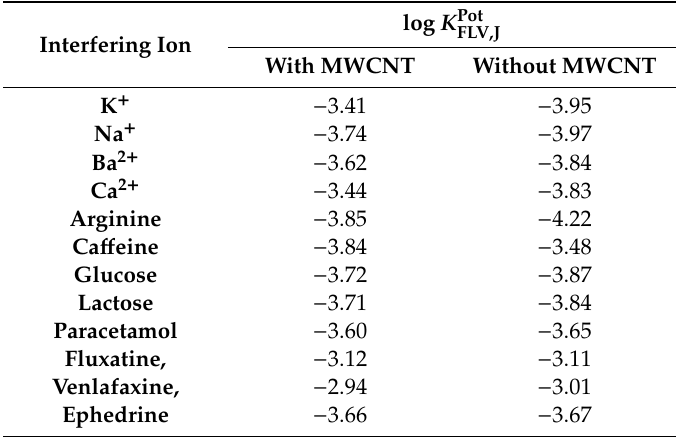
Table 2. The selectivity coe ffi cients (log log K Pot ) of the proposed sensor with and without MWCNT. FLV,J log K Pot FLV,J Interfering Ion With MWCNT Without MWCNT K + − 3.41 − 3.95 Na + − 3.74 − 3.97 Ba 2 + − 3.62 − 3.84 Ca 2 + − 3.44 − 3.83 Arginine − 3.85 − 4.22 Ca ff eine − 3.84 − 3.48 Glucose − 3.72 − 3.87 Lactose − 3.71 − 3.84 Paracetamol − 3.60 − 3.65 Fluxatine, − 3.12 − 3.11 Venlafaxine, − 2.94 − 3.01